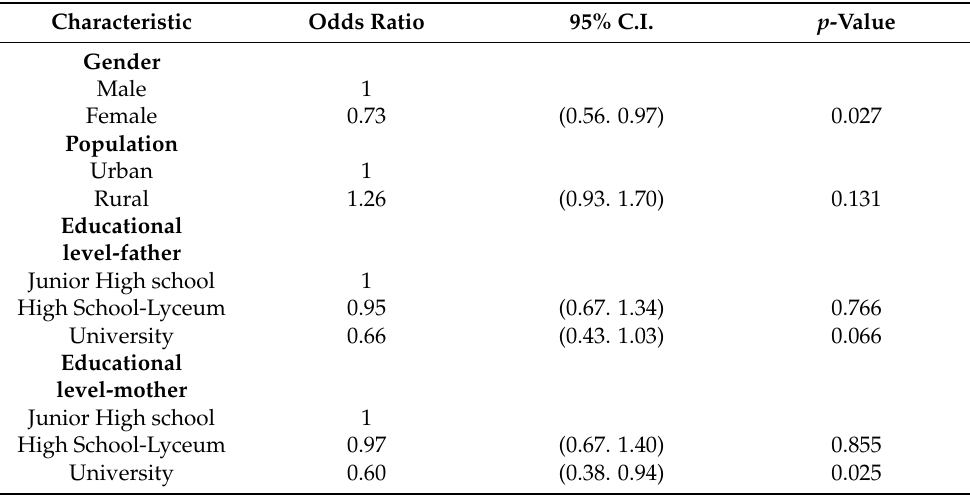
Table 10. Association between need for orthodontic treatment and children’s demographic character- istics (15-y.o.). Results from a multivariable logistic regression model. Characteristic Odds Ratio 95%